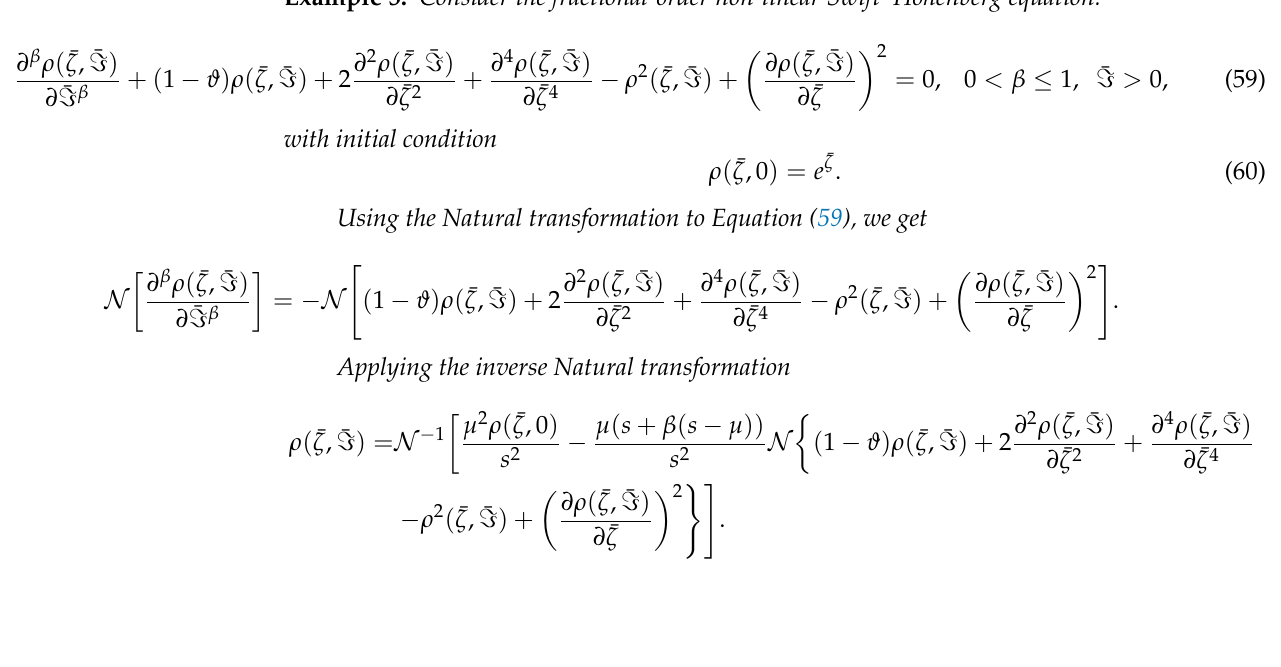
Figure 11. The first graph of analytical solution of β = 0.6 and second is β = 0.4 for Example